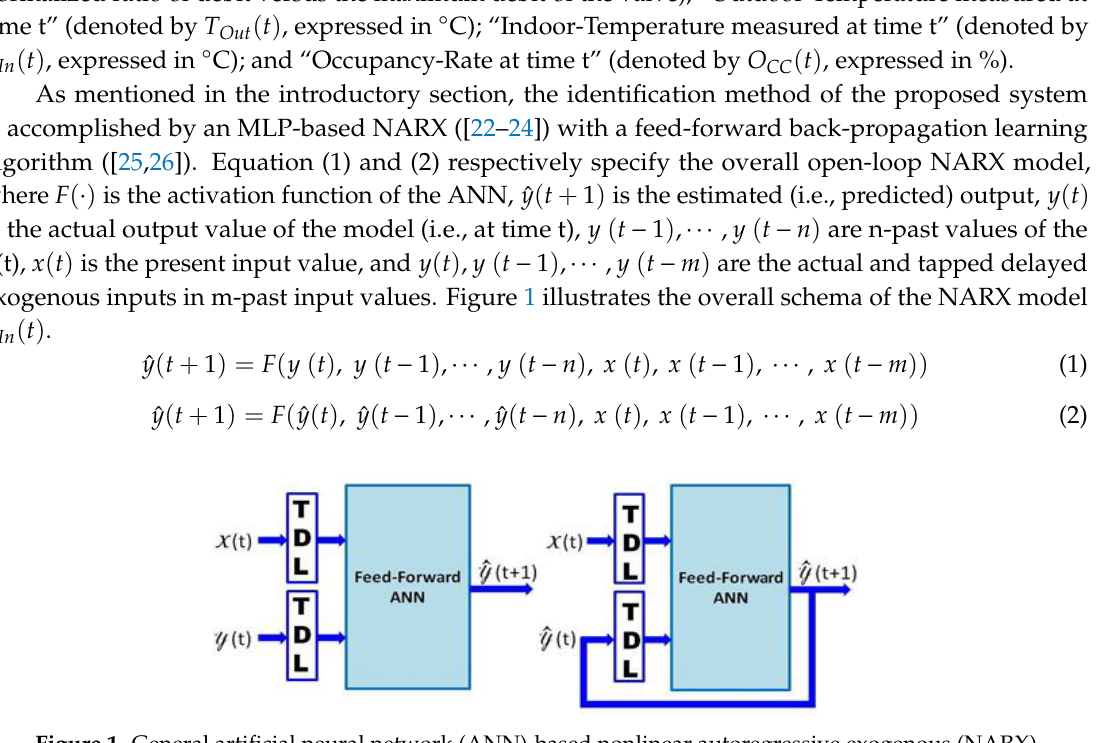
Figure 1. General artificial neural network (ANN)-based nonlinear autoregressive exogenous (NARX) model: open-loop (left) and closed-loop (right) architectures.